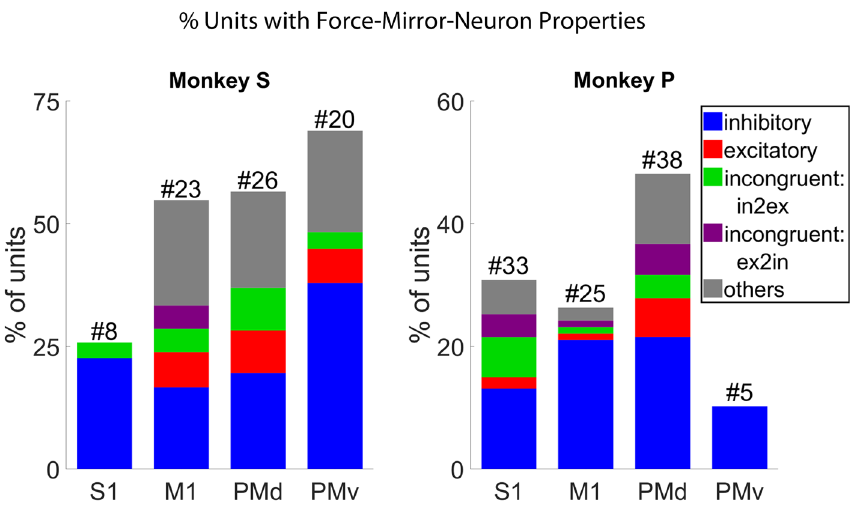
Figure 6. Percentage of well isolated MN single units from cS1, rM1, PMd, and PMv that showed significant (F-test, BH post-hoc adjusted for the number of units in the population) fit to grip-force during all four blocks of data (two manual and two observational) for each NHP. The different color bars represent congruent inhibitory (blue), excitatory (red), incongruent inhibitory to excitatory (green), incongruent excitatory to inhibitory (purple), and other (gray) unit responses. The percentage (y-axis) shows how many units (# at top) are significant for force from units present in all four data blocks. See Fig. S11–S12 for a breakdown of units by trial